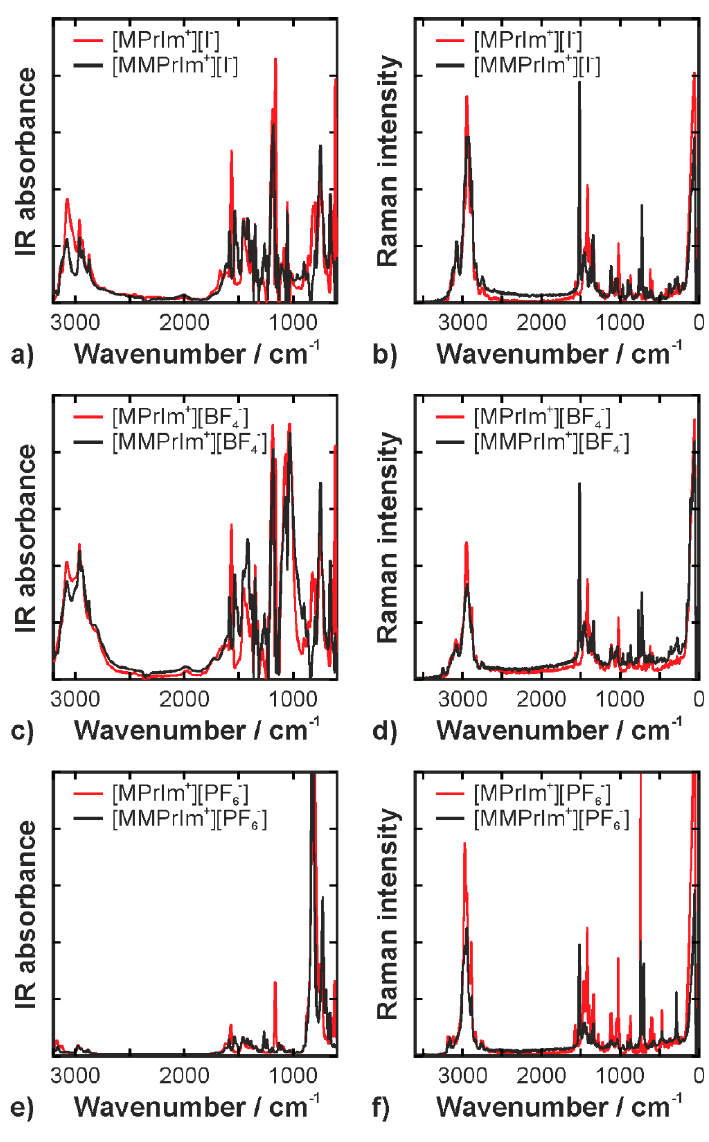
Figure 3. Full range infrared (panels ( a , c , e )) and Raman (panels ( b , d , f )) spectra; ( a ) and ( b ) show the data of the iodide ILs; ( c ) and ( d ) show the data of the tetrafluoroborate ILs; ( e ) and ( f ) show the data of the hexafluorophosphate ILs.